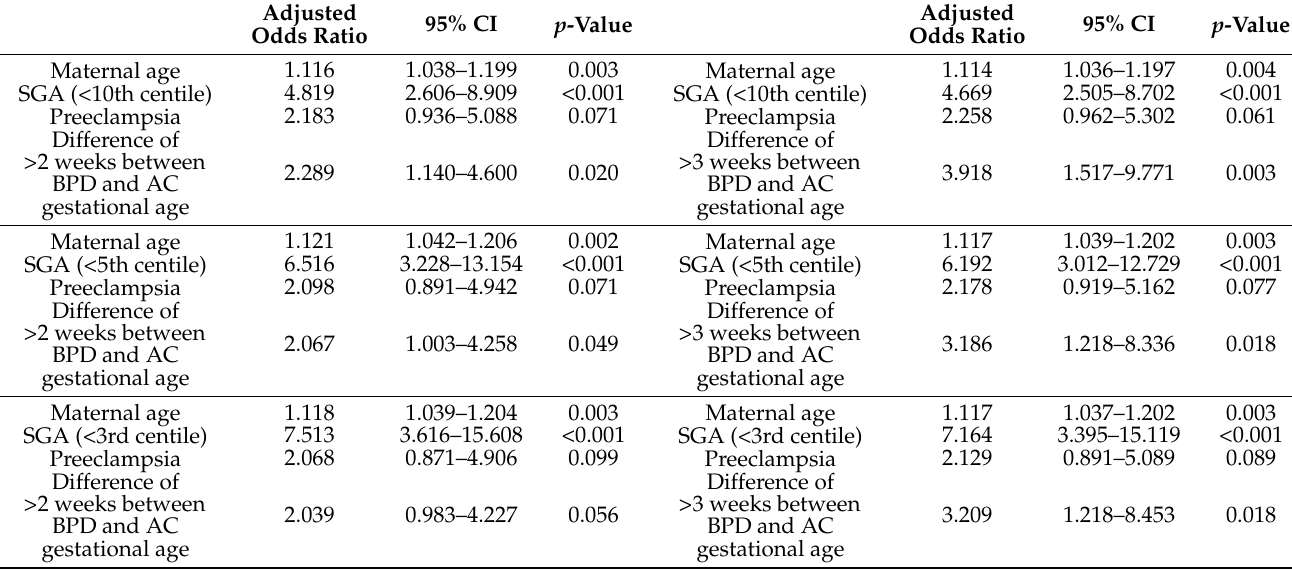
Table 3. Logistic regression analysis of the risk factors for placental abruption.